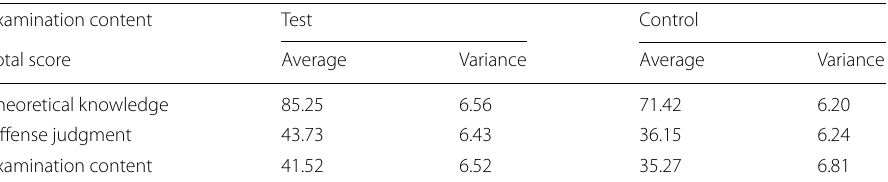
Table 7 Intrusion test results